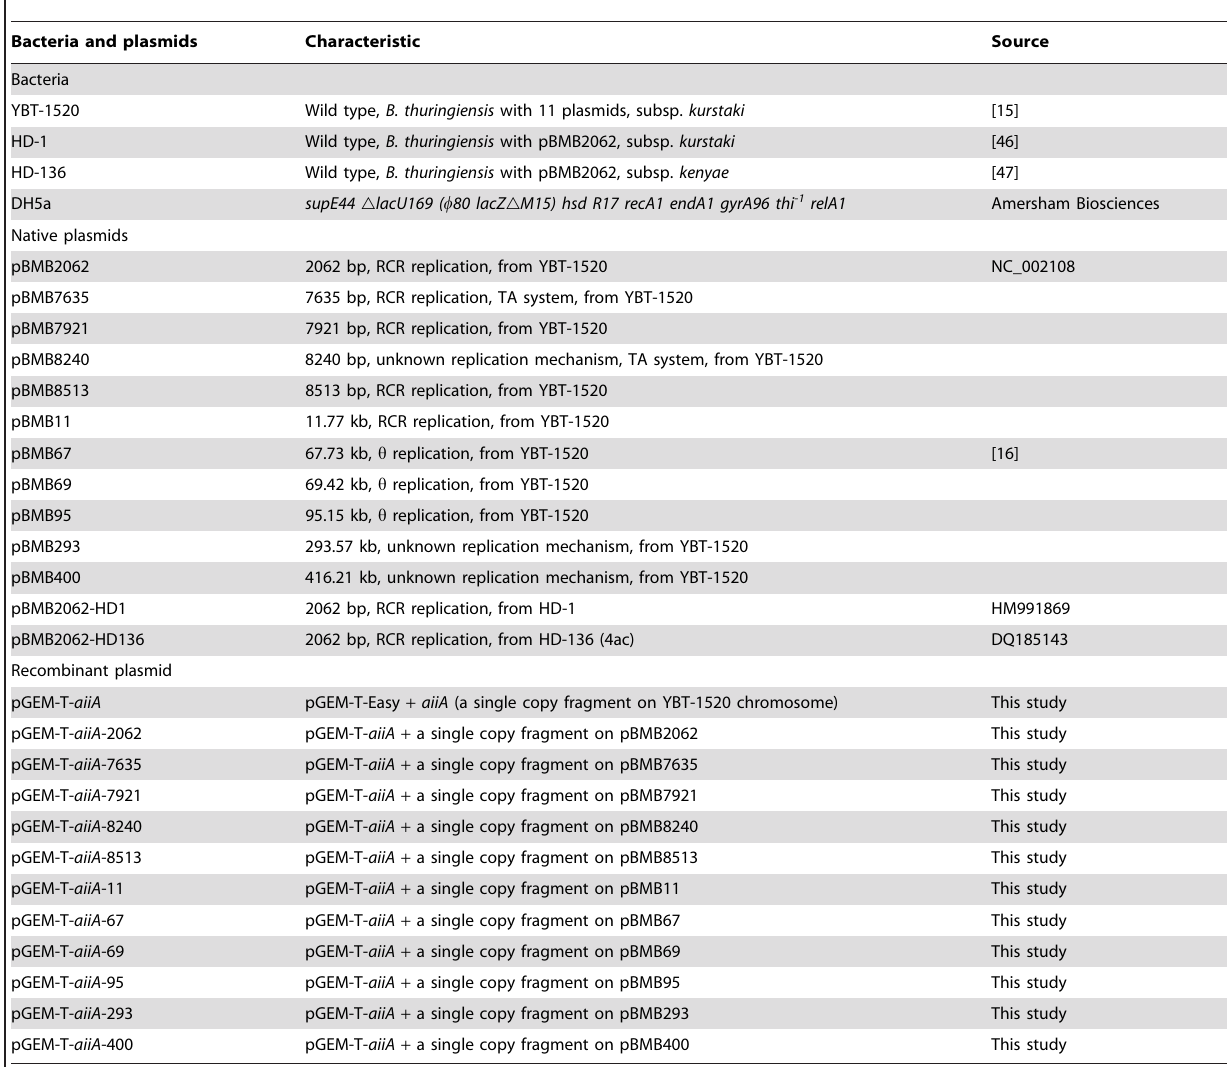
Table 3. Strains and plasmids used in this study.